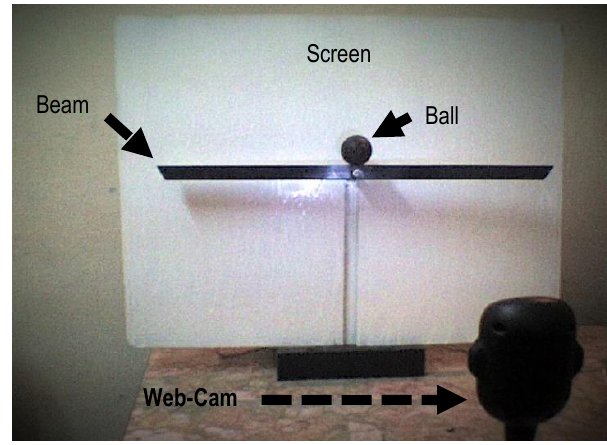
Fig. 2. Hardware implementation of Ball and Beam system